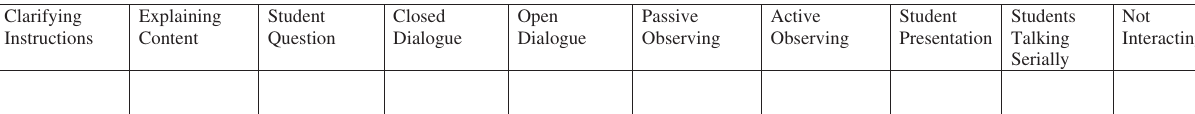
FIG. 7. A copy of the RIOT-based worksheet given to the TAs.